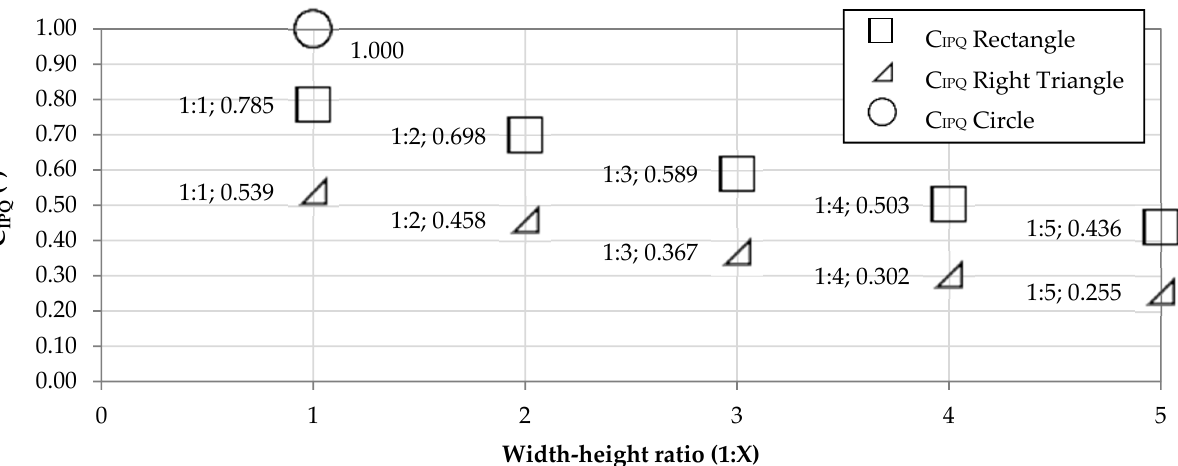
Figure 3. Comparison of values of C IPQ for different geometric shapes according to their width-height ratio for rectangles and base-height ratio for right triangles according to Equation (2).